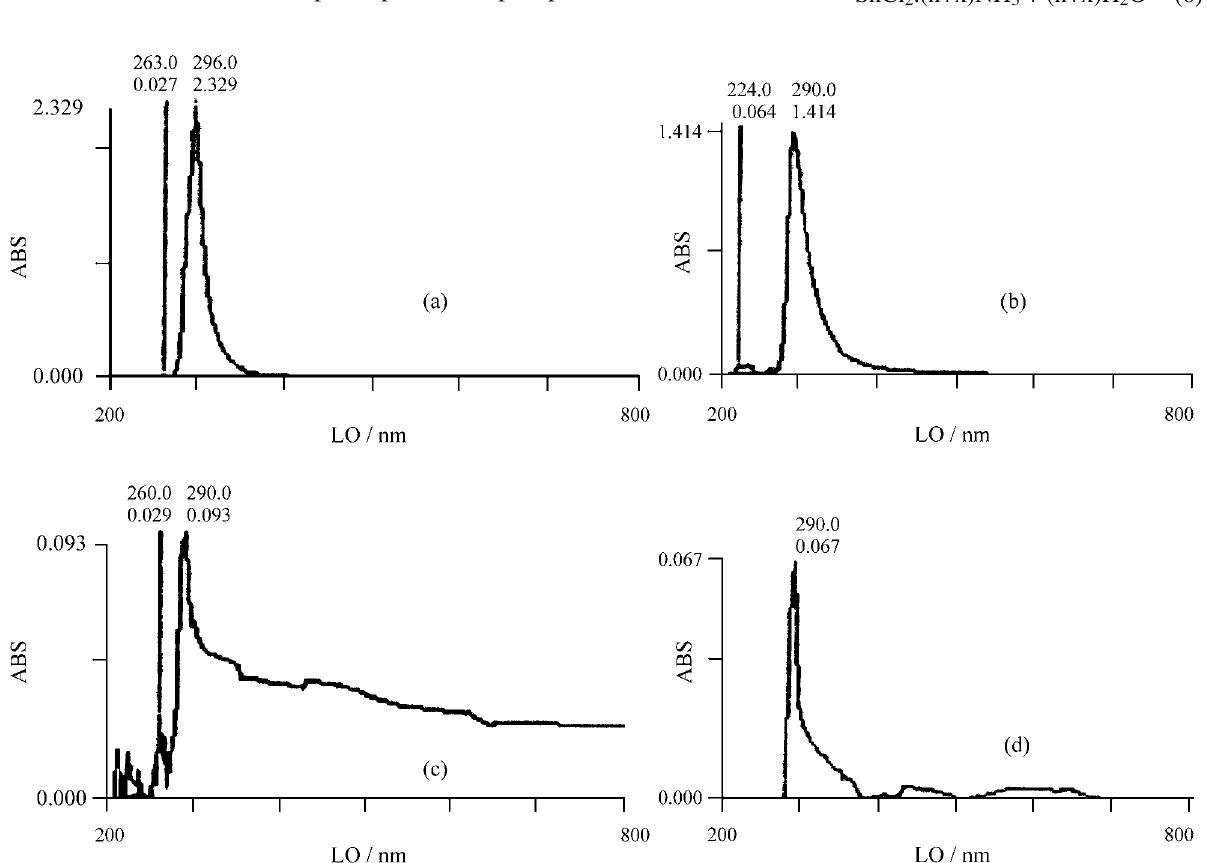
Figura 4. Espectros de UV-Visible características para una disolución 0.2 M de SnCl 2 correspondientes a muestras líquidas obtenidas del filtrado del sistema SnCl 2 -NH 4 OH-H 2 O a diferentes valores de pH: (a) pH 1.85. (b) pH 2.60, (c) pH 4.94, (d) pH